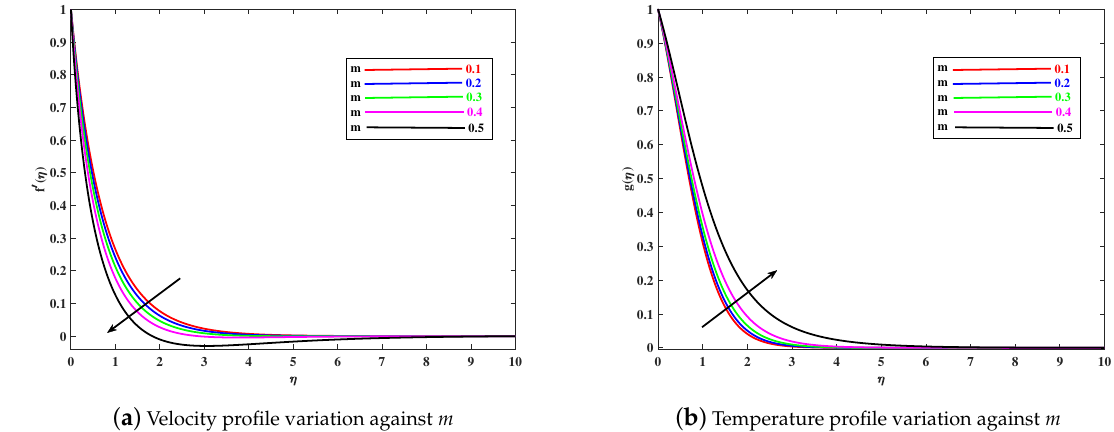
Figure 3. Effect of m to influence the momentum and thermal profile.